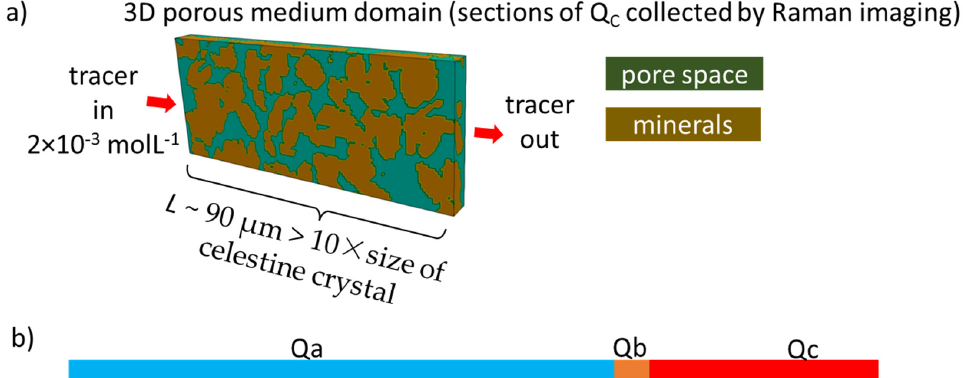
Figure 2. ( a ) An example of a 3D domain from Raman tomographs considered for numerical tracer experiments at the pore scale in Section 3.3; ( b ) 1D representation of domain considered for reactive transport simulation at the continuum scale in Section 3.4, with Q a , Q b , and Q c representing the inert pillared porous medium, the intermediate zone with pillars and celestine, and finally the reactive porous medium, respectively.